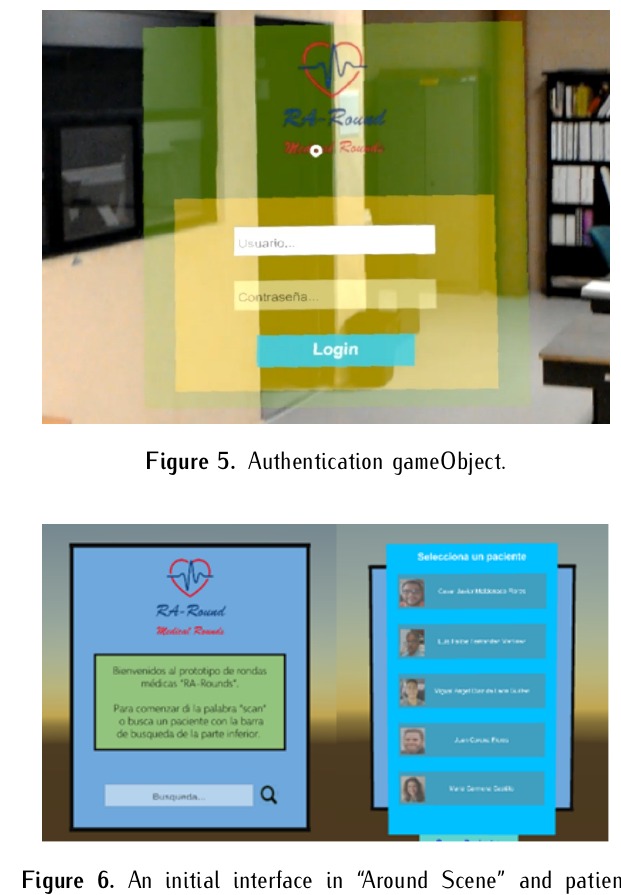
Figure 8. Selected profile view in Around